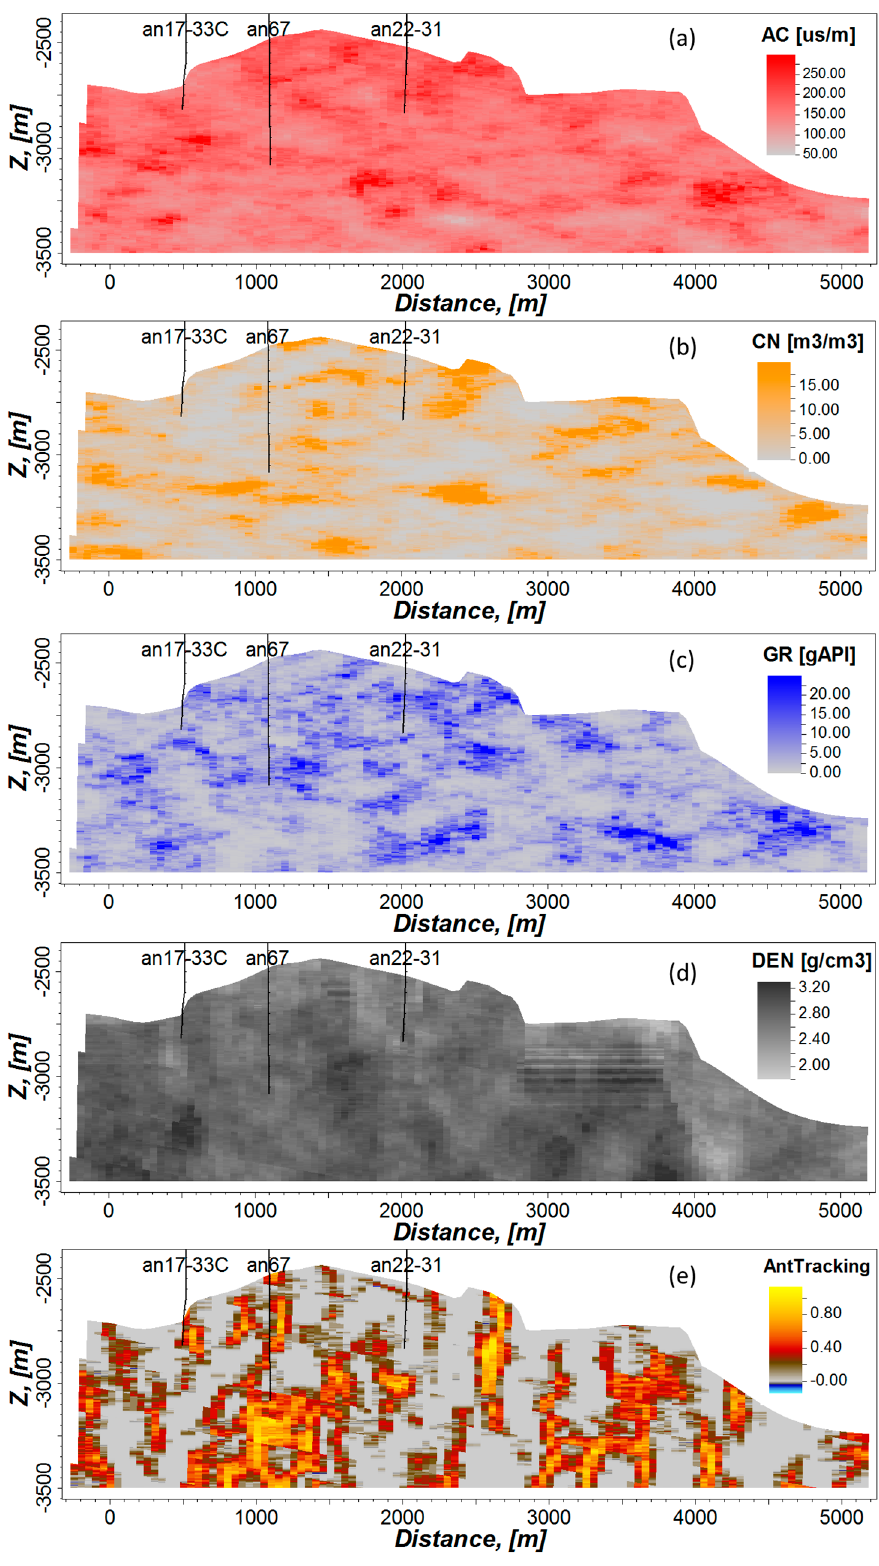
Figure 12. Intersections of 3D ANN inputs, AC ( a ); CN ( b ); GR ( c ); DEN ( d ); and ant tracking results ( e ).